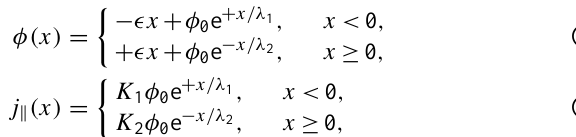
= 0 . 2 mA/kV m 2 , K = 1 mA/kV m 2 ). The 1 2 = 5 S is P